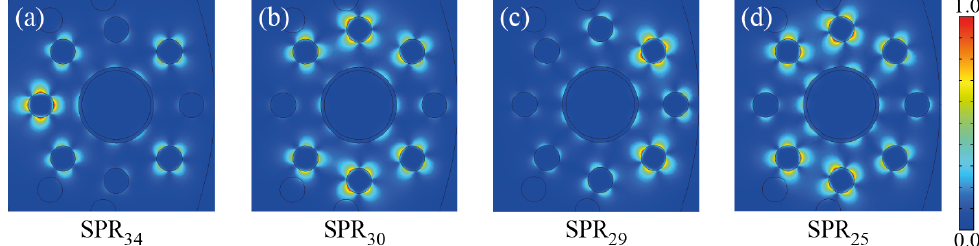
Figure 3. Plasmonic field profiles of SPR modes from Figure 2. Results are for ( a ) SPR 34 , ( b ) SPR 30 , ( c ) SPR 29 , and ( d ) SPR 25 , where the subindex indicate the corresponding mode number in Figure 2.